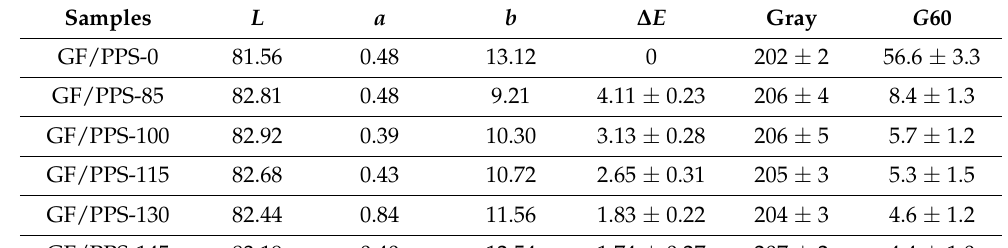
Table 1. Color difference of the GF/PPS composites after thermal aging.